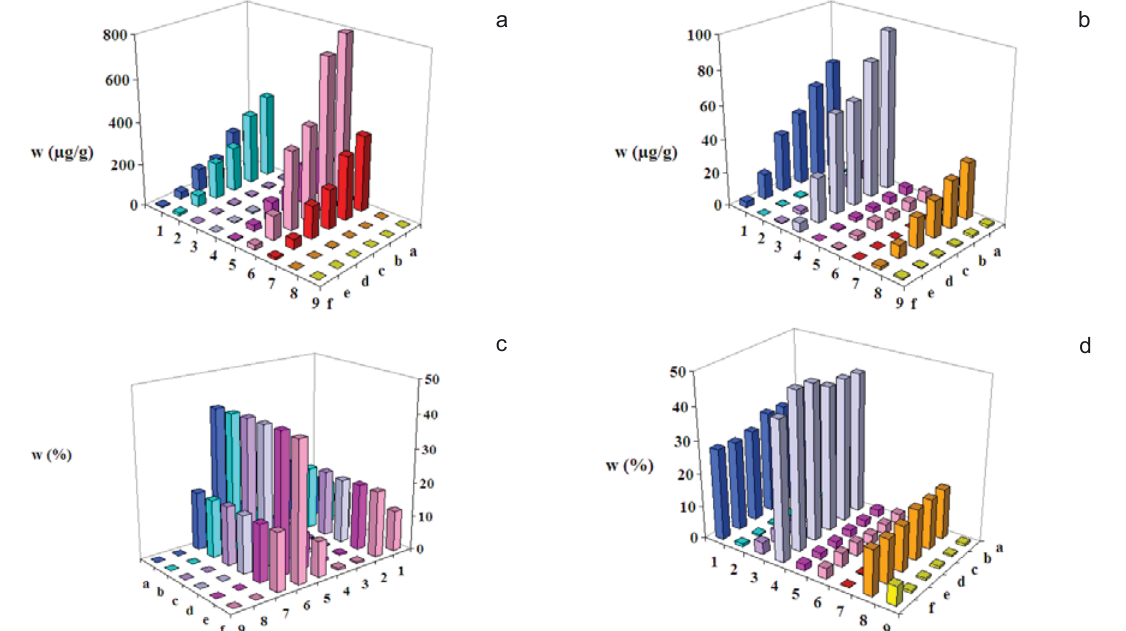
Figure 2. The effect of extraction methods on the amount (a, b) and representation (c, d) of monoterpenes in needles P. pungens and leaves J. regia L